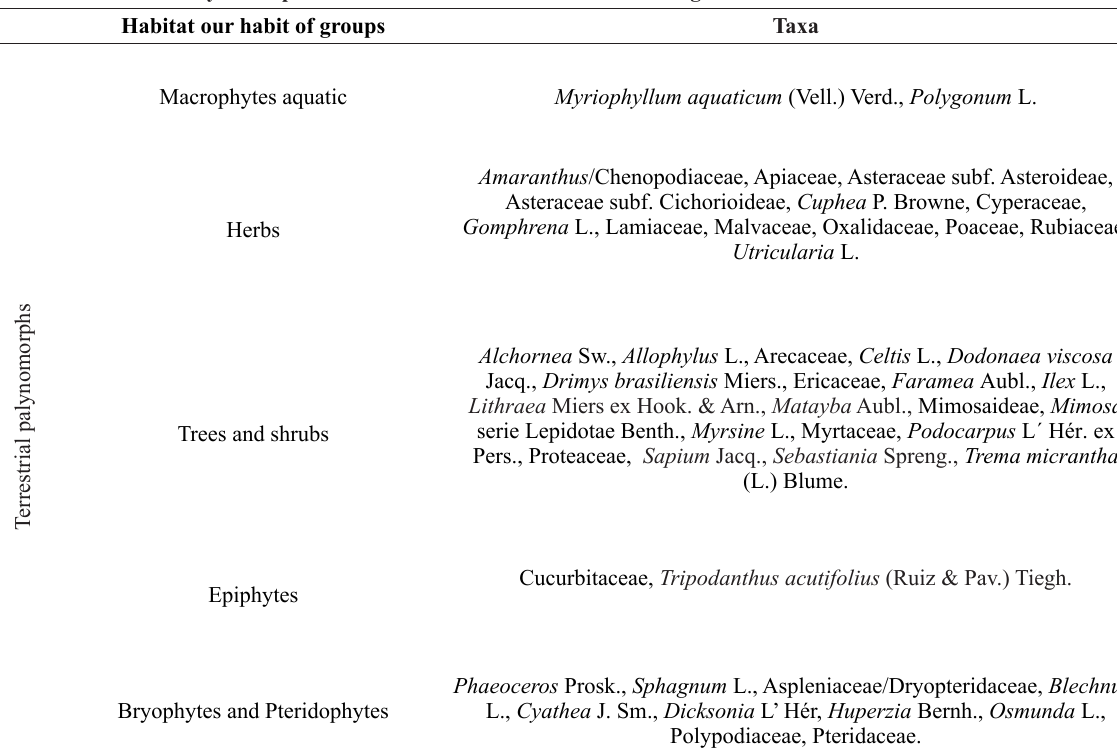
Palynomorphs identified in the PCSC-3 core according to their habitat and